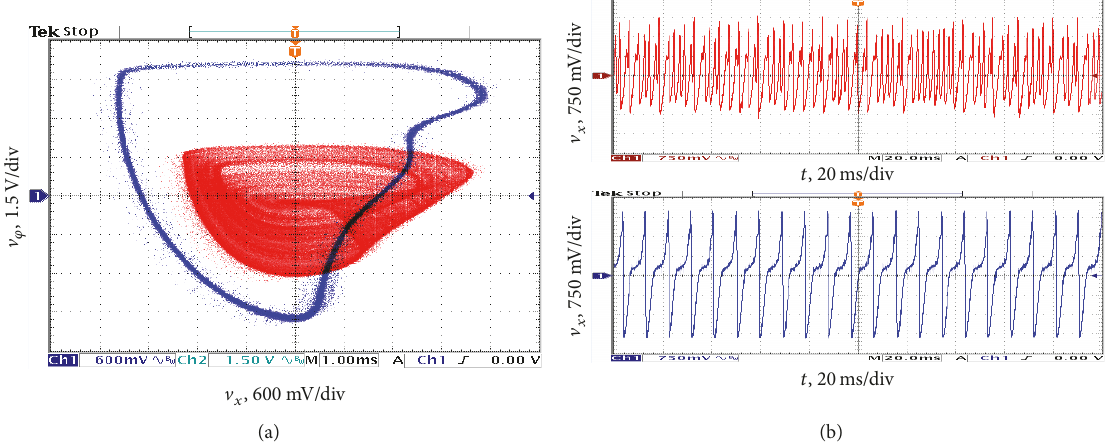
Figure 12: Experimentally measured hidden coexisting asymmetric attractors while repeatedly switching on and off the experimental power supply. (a) Phase portraits in the V 𝑥 - V 𝜑 plane. (b) Time series of the variable V 𝑥